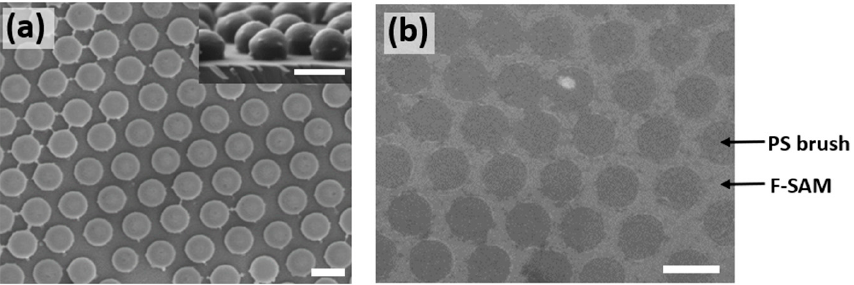
Figure 1. Schematic of the overall experimental process: ( i ) Multilayered colloidal crystal structure; ( ii ) O 2 plasma etching of the surface layer of the colloidal crystal; ( iii ) peeling of the surface layer of the colloidal crystal using a PDMS stamp; ( iv ) transfer of the colloidal crystal monolayer to the PS brush substrate; ( v ) resulting non-close-packed hemispherical colloidal crystal monolayer on the PS brush substrate; ( vi ) O 2 plasma etching to remove the exposed areas of the PS brush layer; ( vii ) F-SAM deposition on the exposed surfaces; ( viii ) F-SAM-patterned guiding template upon the removal of the colloidal particles; ( ix ) area-selective dewetting of the BCP thin film; ( x ) microphase separation of the BCP film via solvent vapor annealing.